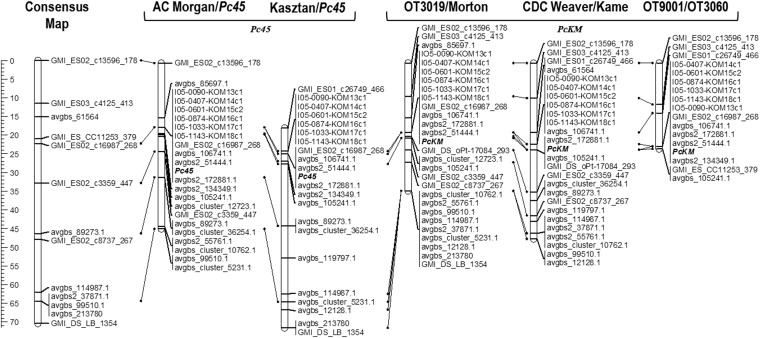
Linkage maps showing the common location of the Pc45 and PcKM crown rust resistance genes. The “Consensus Map” refers to Mrg08 (Chromosome 12D) of the chromosome anchored consensus genetic map (Chaffin et al. 2016).